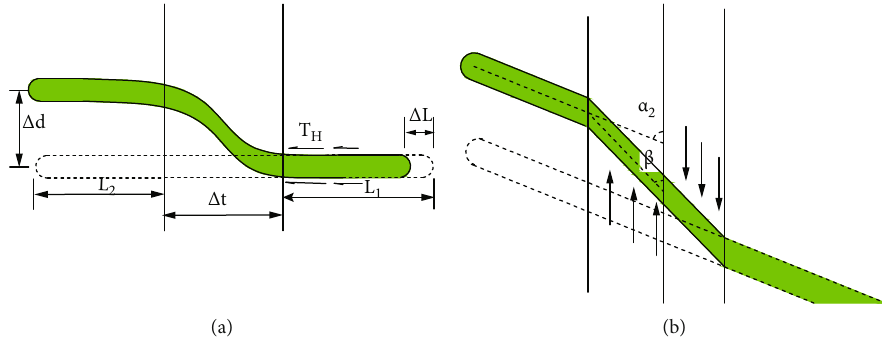
Figure 10: Schematic diagram of root stress and deformation: (a) vertical root deformation; (b) inclined root Table 7: Root parameters.